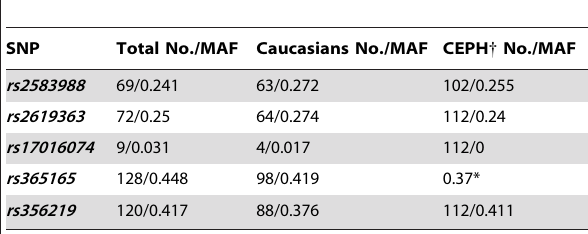
Table 3. SNPs analyzed in the study with allele